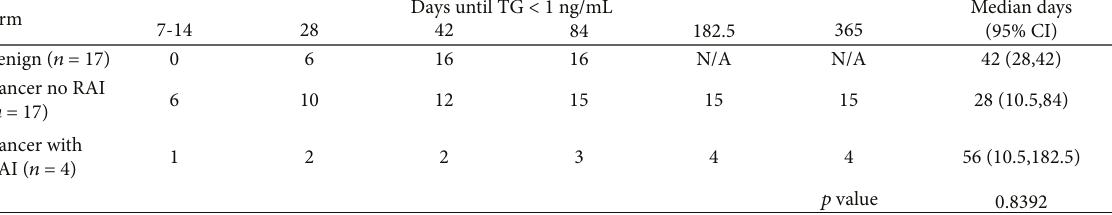
Figure 4: Cumulative number and percentage of subjects who achieved undetectable TG < 1 0 ng/mL at each time point for each